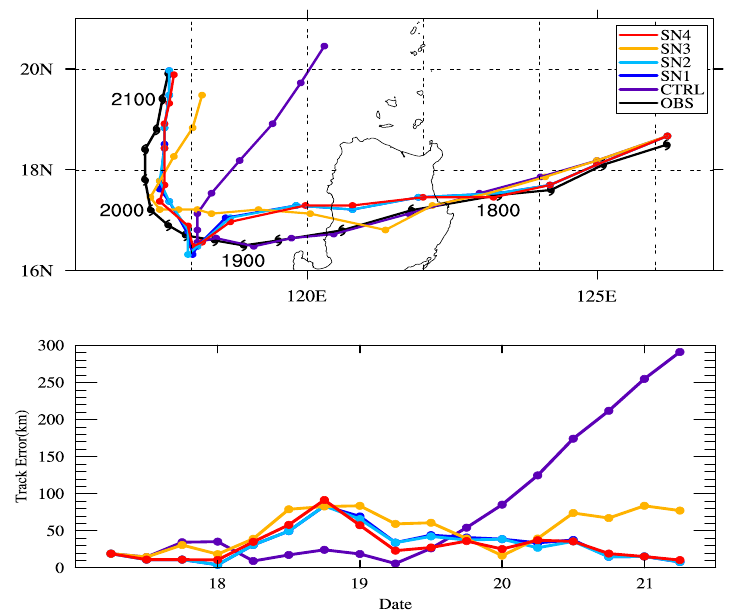
Figure 3. Simulated typhoon tracks and temporal evolution of track errors (unit: km) in the first group of sensitivity tests; where black, purple, blue, sky blue, brown, red correspond with observation, CTRL, SN1, SN2, SN3, SN4, respectively.